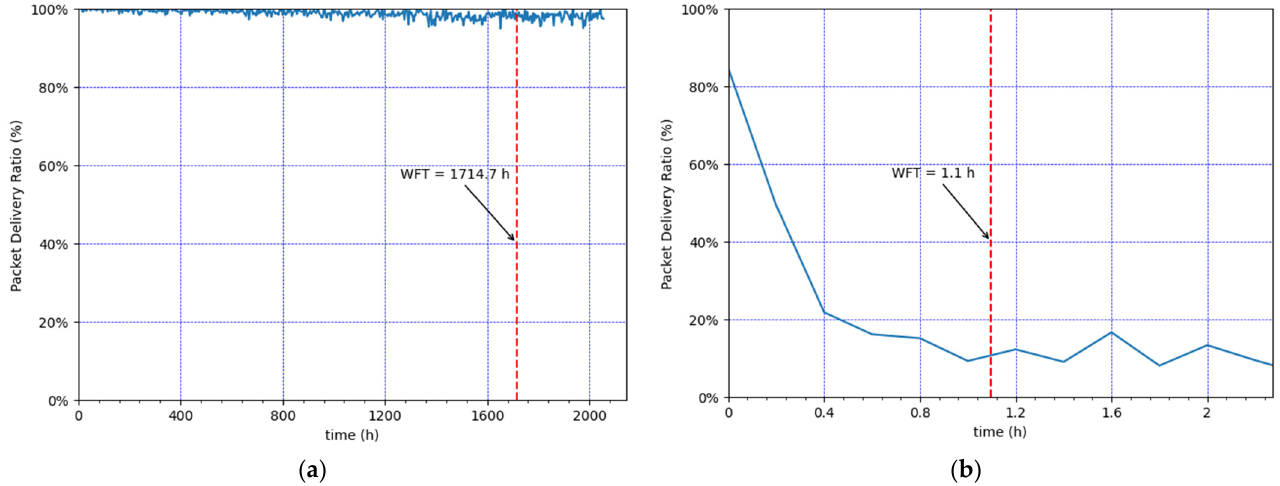
Figure 8. Instantaneous PDR after WFT. ( a ) Lowest load: 30 CEDs, using an EDL of 0.9 packets/h. ( b ) Highest load: 100 CEDs, using an EDL of 18 packets/h.